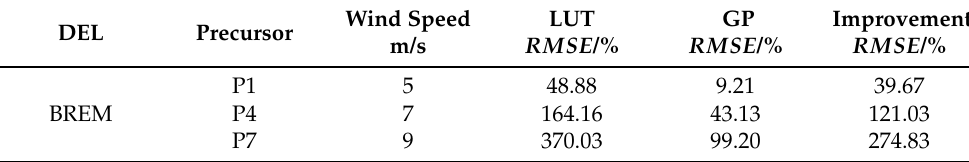
Table 5. RMSE error of blade root flapwise moment.